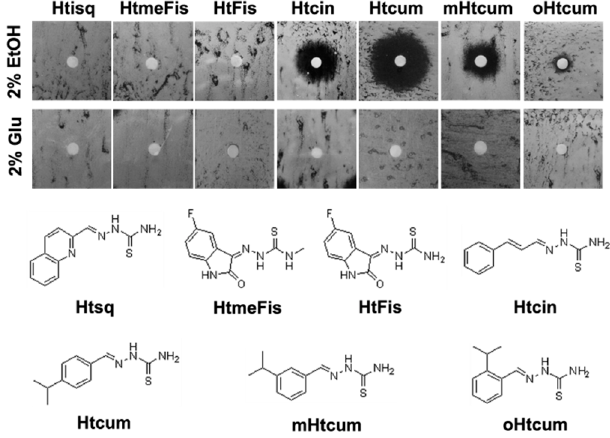
Figure 1. Structure of tested compounds and their effect on yeast oxidative growth. Inhibition halos were evaluated on glucose and ethanol through the agar disk-diffusion method.